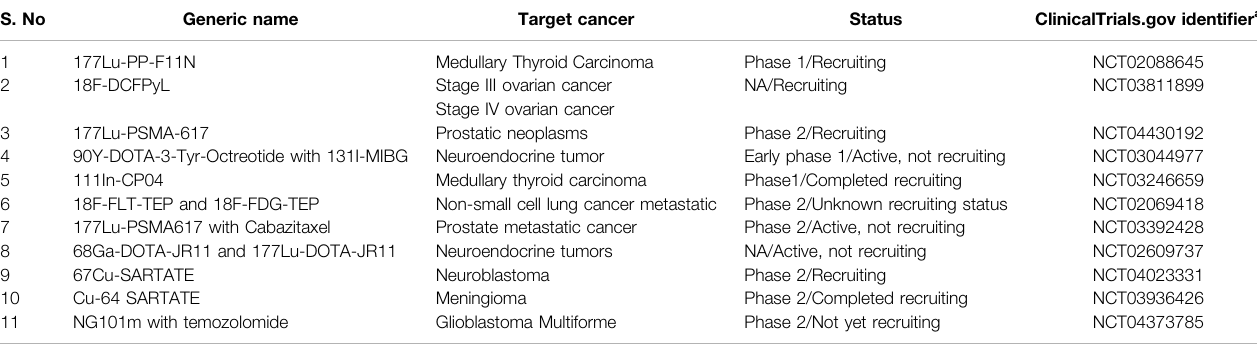
TABLE 2 | Recent clinical trials of cancer theranostic as reported by